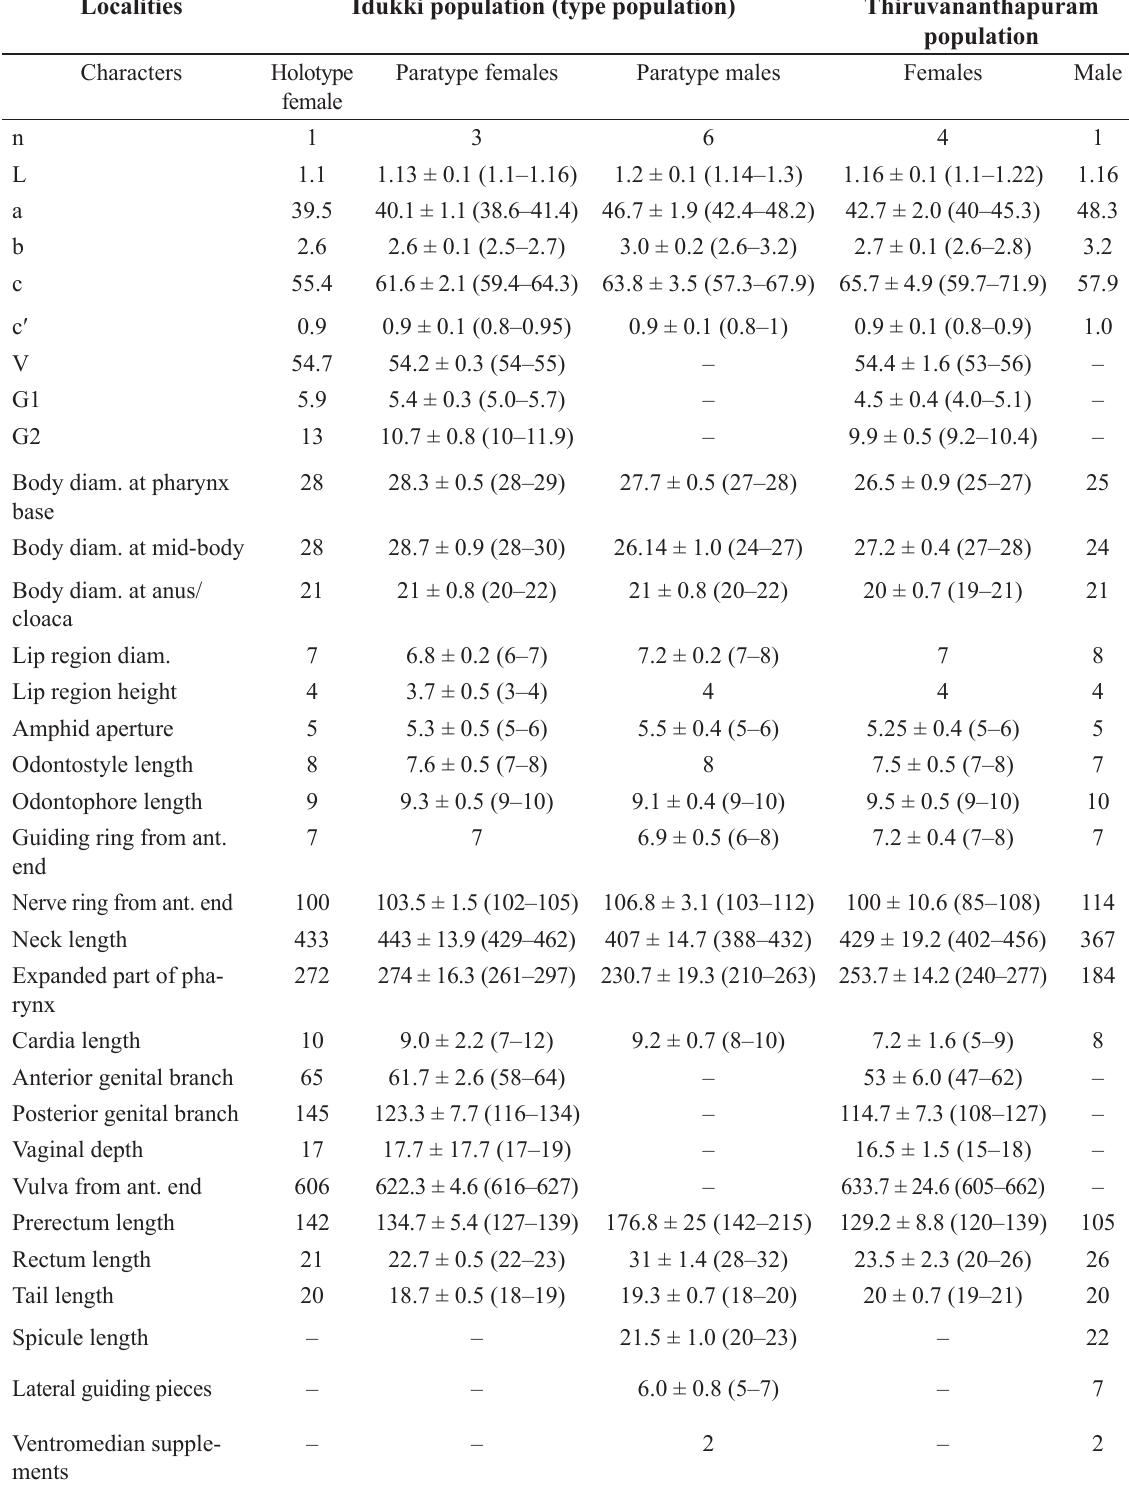
Table 6. Measurements of Axonchium microspiculum sp. nov. All measurements in µm except L in mm, and in the form: mean ± s.d.